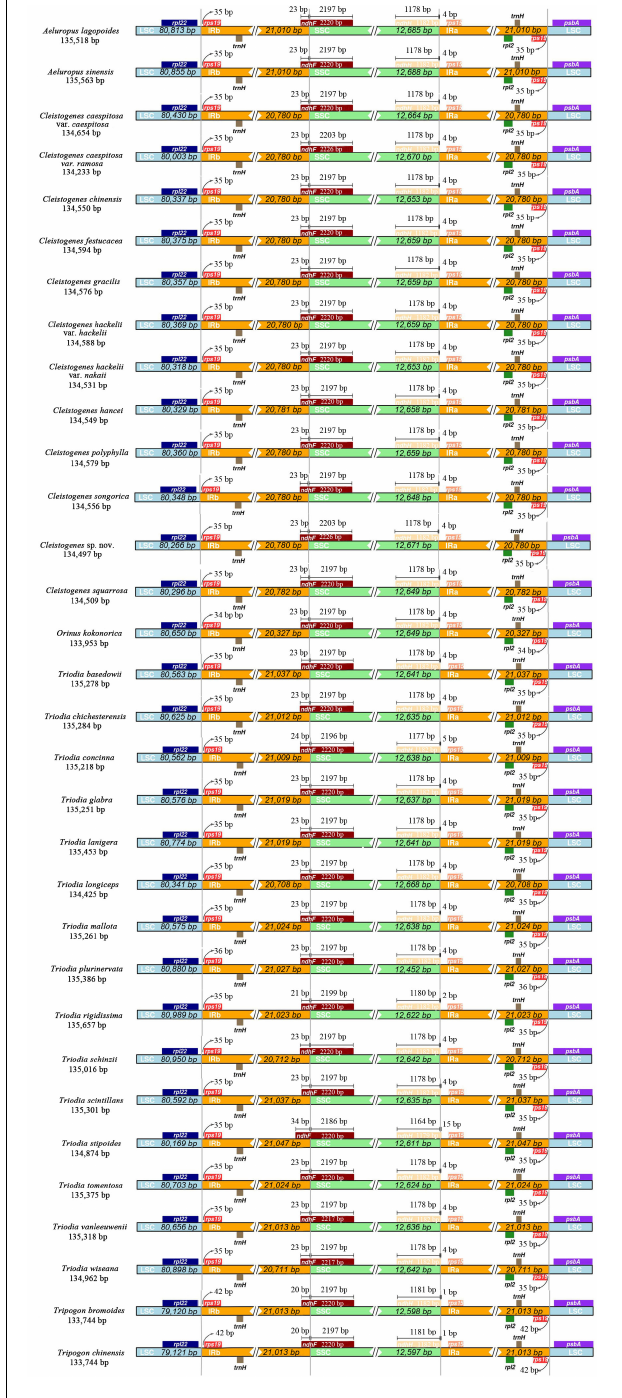
FIGURE 3 | Comparison of the boundaries between LSC/SSC and IR regions among the 32 plastomes.